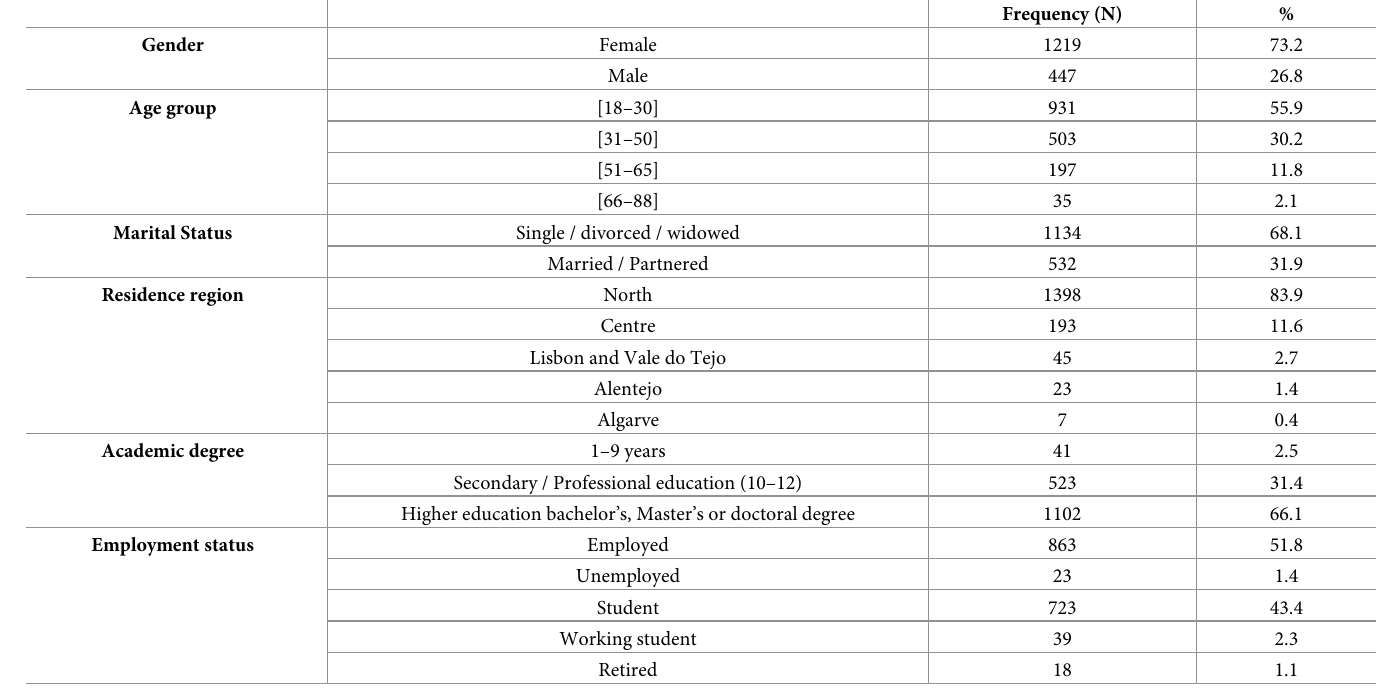
Table 1. Sociodemographic characteristics of the sample (N =